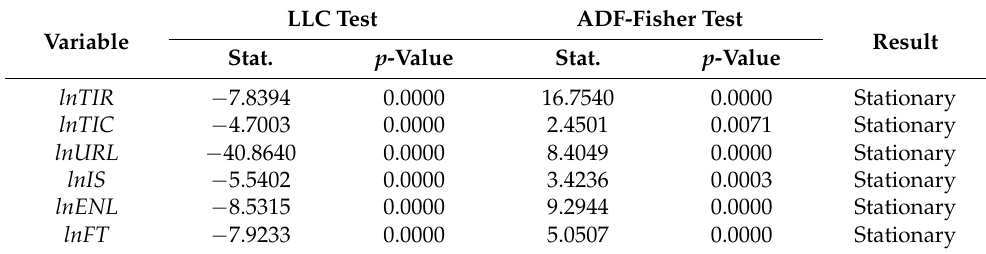
Table 4. Results of panel unit root